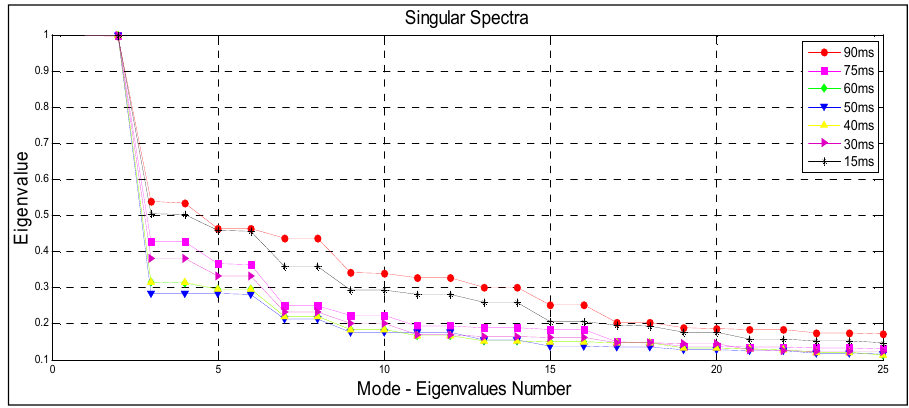
Figure 6. Window length optimisation using seven different values of the frame length.